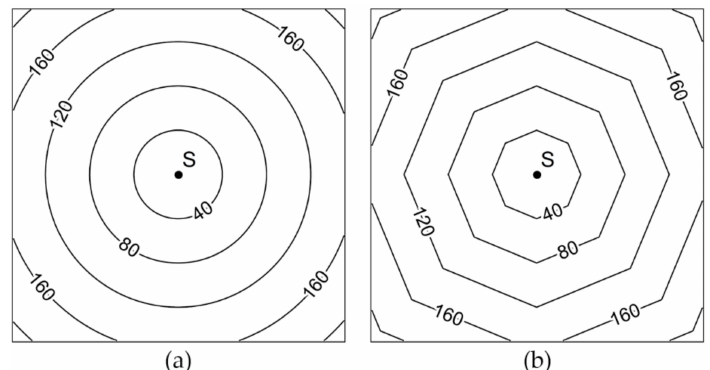
Figure 1. Comparison between the ( a ) true Euclidean distance and ( b ) Euclidean distance calculated using the conventional cost distance function.